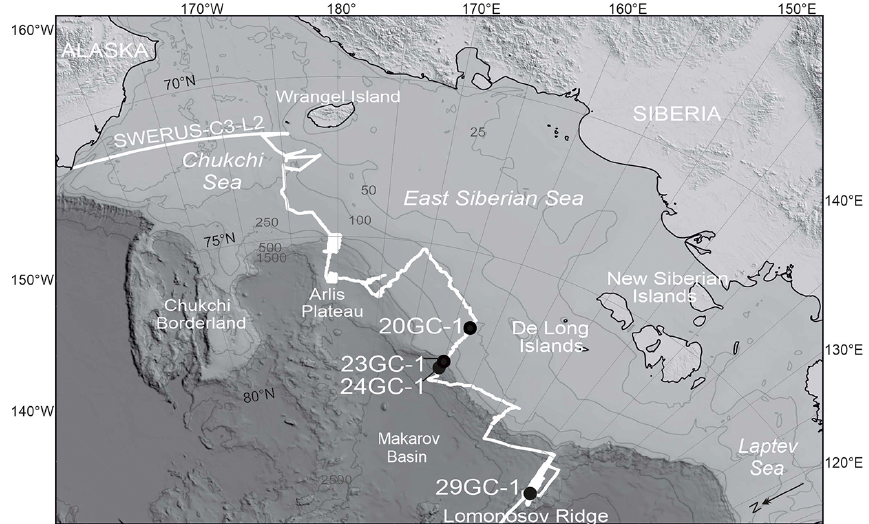
Figure 3. The locations of studied cores 20-GC1, 23-GC1, 24-GC-1, and 29-GC1, and the route of leg 2 of the SWERUS-C3 2014 expedition (white line). Original map by O’Regan et al.